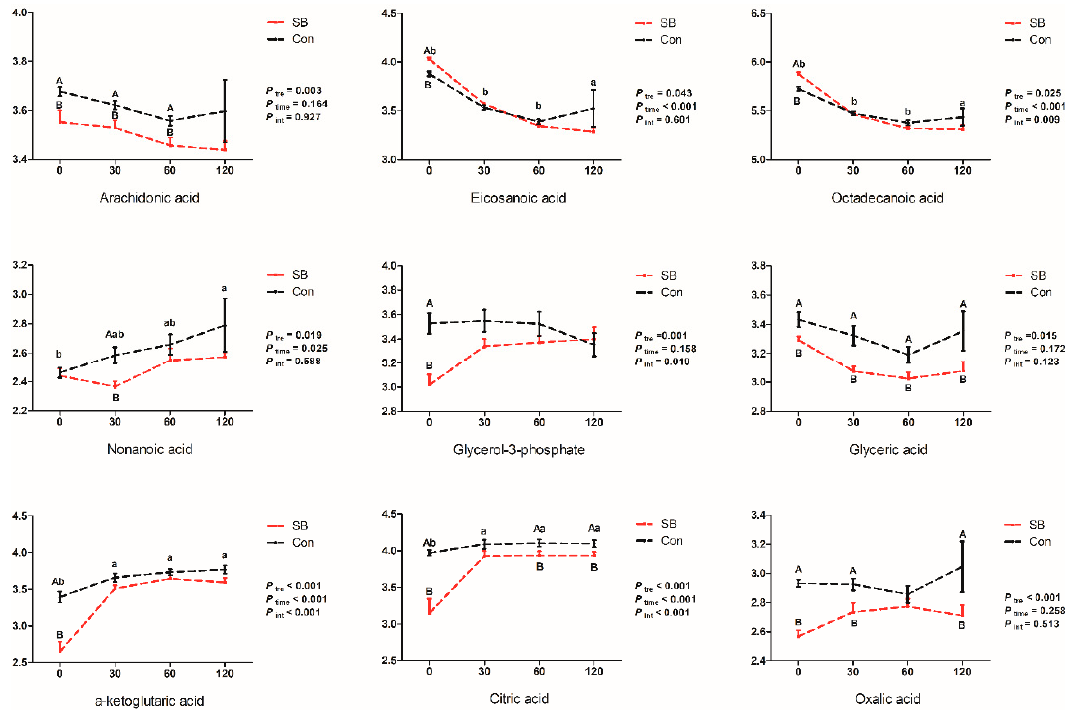
Figure 8. Dynamic changes of the relative concentration of fatty acids and organic acids. X-axis presents the relative concentrations of corresponding metabolites with Log processing of the peak area. Di ff erences were analyzed by two-way ANOVA using PROC MIXED with time and SB treatment as the main factors followed by post-hoc analysis in SAS. Ptre, Ptime, Pint represents the significances of SB treatment, time, and interaction e ff ects, respectively. Superscript with A or B means significant di ff erence between control group (Con) and sodium butyrate group (SB). Superscript with a, b, and c means significant di ff erence over